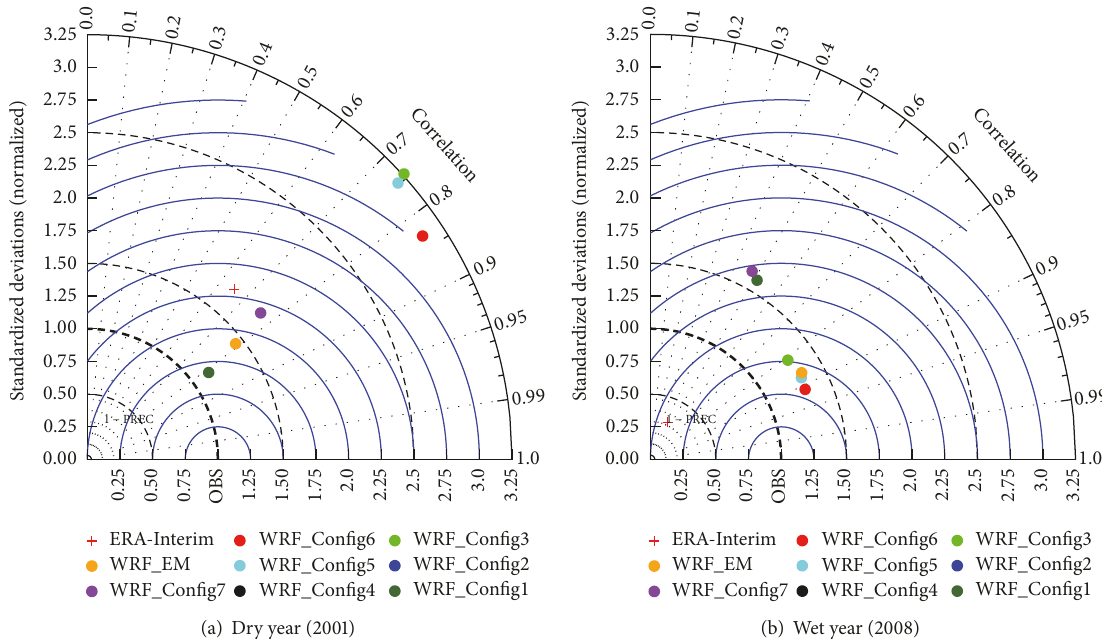
Figure 6: Taylor diagram showing the statistical summary for the forest zone for the (a) dry year (2001) and (b) wet year